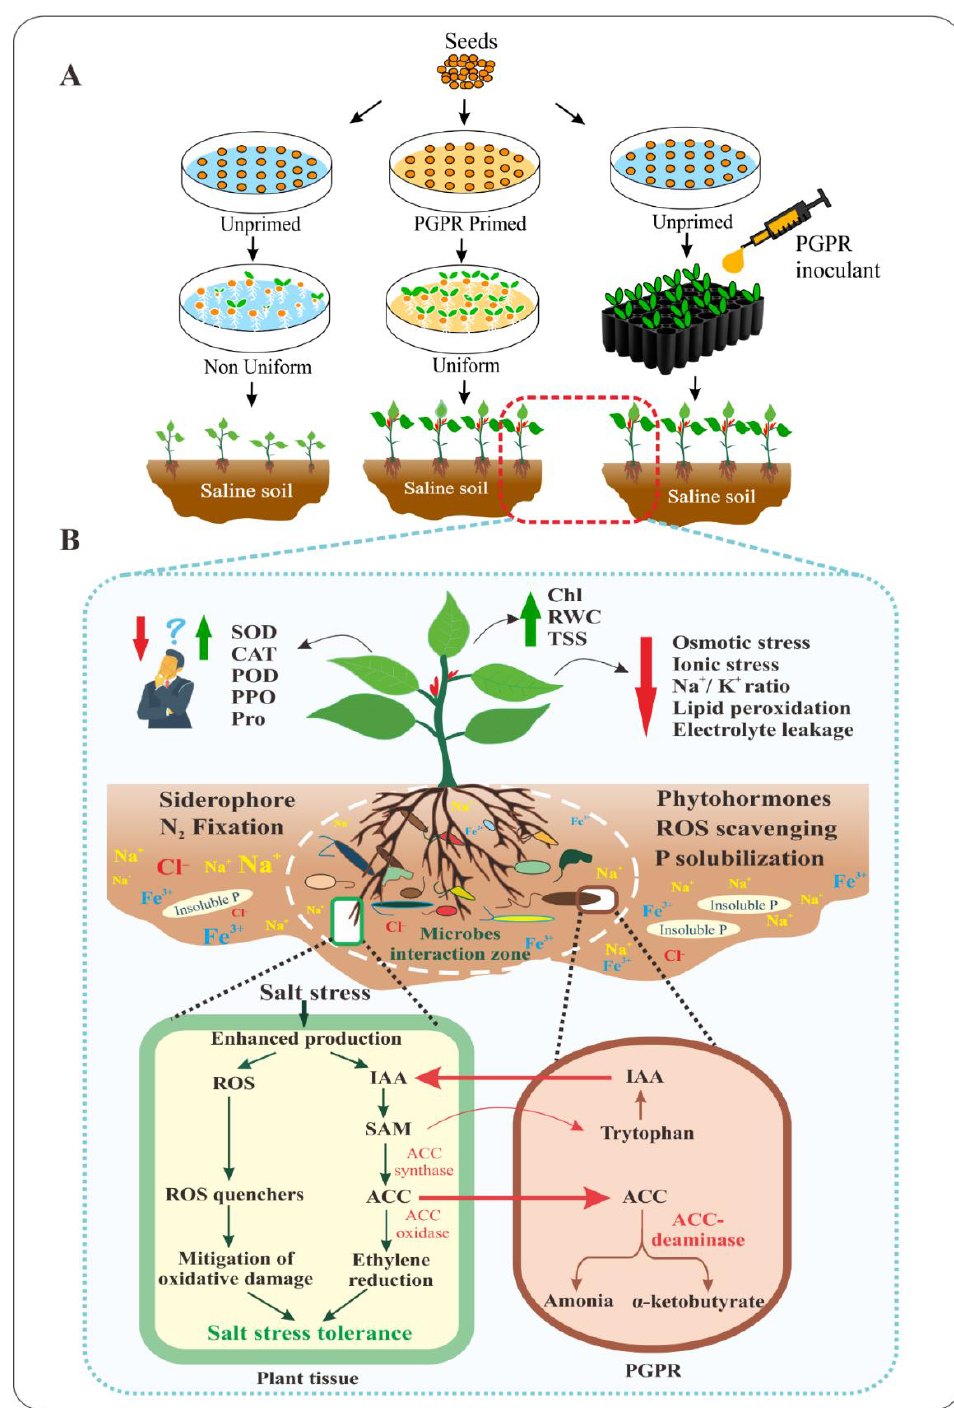
Figure 1. Roles of PGPR in alleviating salinity stress in plants. ( A ) represents the application of PGPR as microbial beneficial tools in seed biopriming technique and as green bioinoculants in seedlings treatment. The primed seeds demonstrate rapid germination and robust, uniform seedlings. ( B ) shows positive effects of PGPR on vegetative parameters and physio-biochemical indexes in PGPR-inoculated plants via various mechanisms e.g., production of OS, AEs to reduce osmotic and ionic stress, and EPS suppress toxic ions uptake and ion exposure. The fluctuation of AEs and OS profiles in PGPR-treated plants is also displayed in the left panel. The middle panel demonstrates key characteristics of PGPR including the production of Sid, phytohormones, EPS, N fixation and P solubilization. The lower panel emphasizes the importance of ACC deaminase-producing PGPR in ameliorating the inhibitory effects of excess ethylene on plant growth.